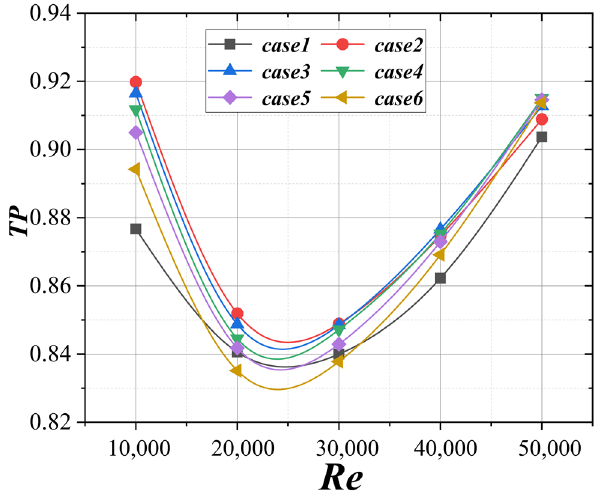
Figure 12. The variation of TP with Re for different channels.